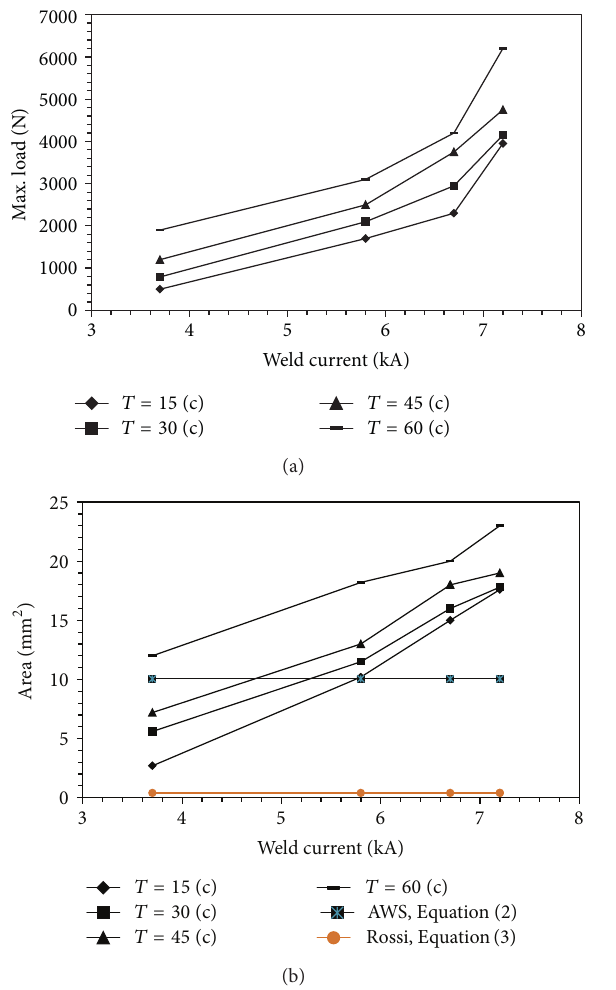
Figure 4: Effect of current of thepeel joints; 𝑑 (a) tensile strength; (b) weld nugget area.